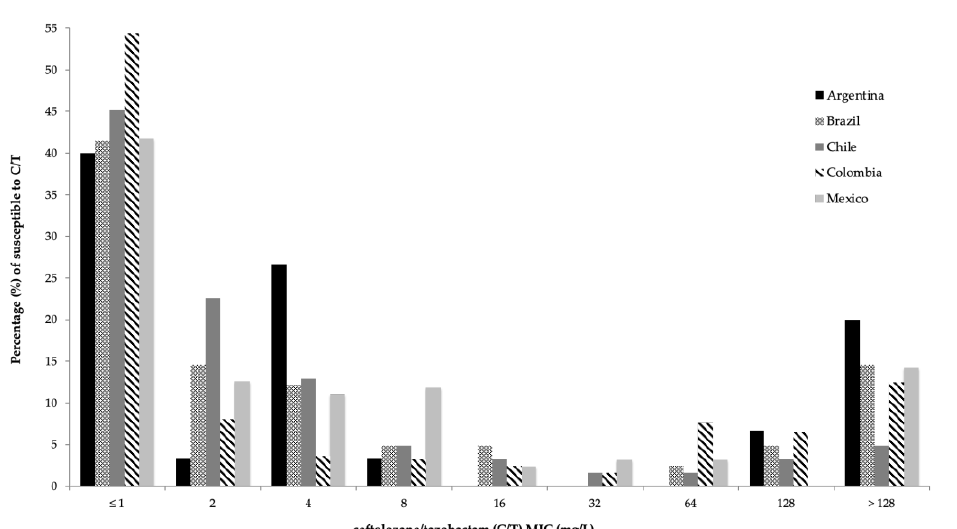
Figure 1. Susceptibility to C/T of clinical isolates of P. aeruginosa in five Latin American countries between 2016 and 2017 in relation to the minimum inhibitory concentration (MIC) to C/T. Each bar represents one of the five countries evaluated.